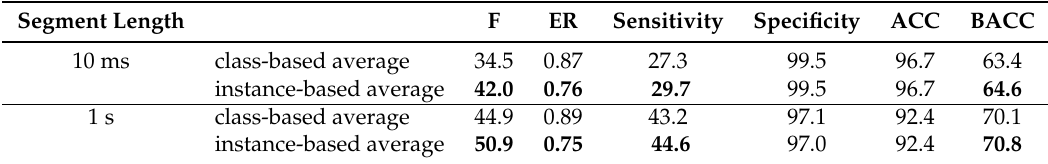
Figure 6. Segment-based F-score for the case study system, 10 ms evaluation segment. Table 1. Segment-based metrics calculated on the case study